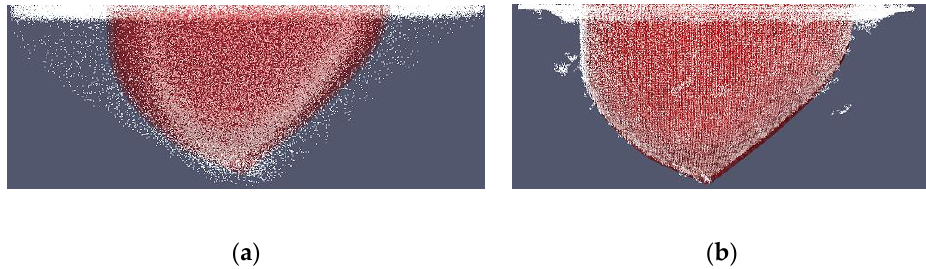
Figure A3. Cumulative approximately aligned 3D point cloud and registered 3D breast surface: ( a ) From IFM O3D302 Camera scan; ( b ) From Ensenso N10-804-18 camera scan.